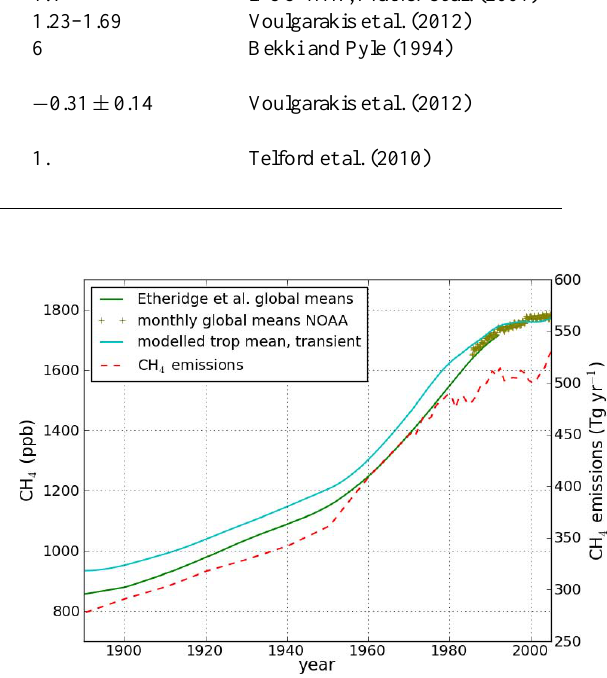
Fig. 4. Observed and modeled evolution of CH 4 mixing ratios be- tween 1890 and 2005. Observation-based global means are calcu- lated by Etheridge et al. (1998) based on ice-core data (green line), and more recent global means are calculated using measurements at South Pole and Alert NOAA stations (green crosses). CH 4 emis- sions implemented in the model are also shown (red dotted line, with scale on the right axis) (Van Aardenne et al., 2001; Spahni et al.,